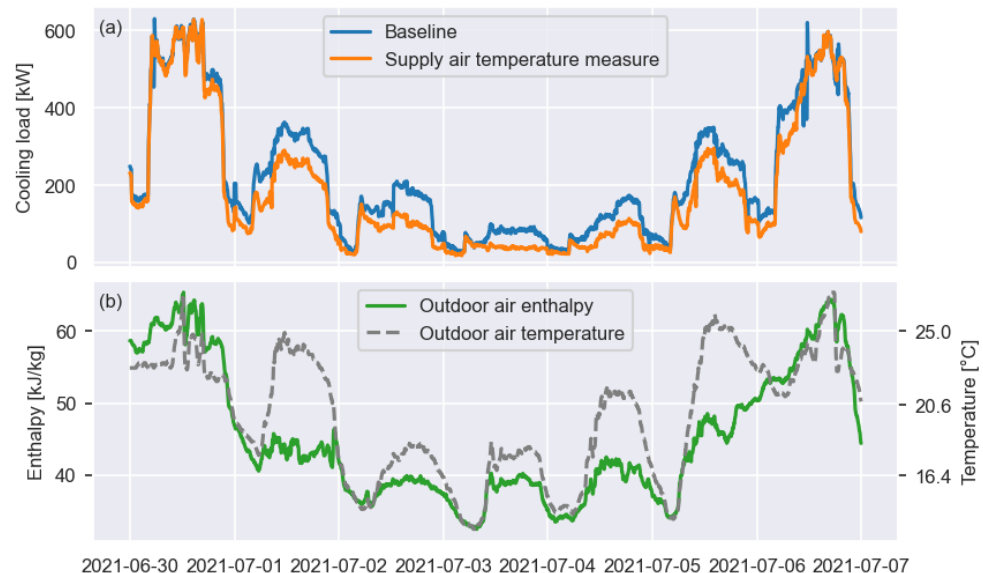
Figure 15. ( a ) Cooling load of a typical week in 2021 for the baseline and proposed supply air temperature reset strategy; ( b ) outdoor air enthalpy and dry bulb temperature for the same week.